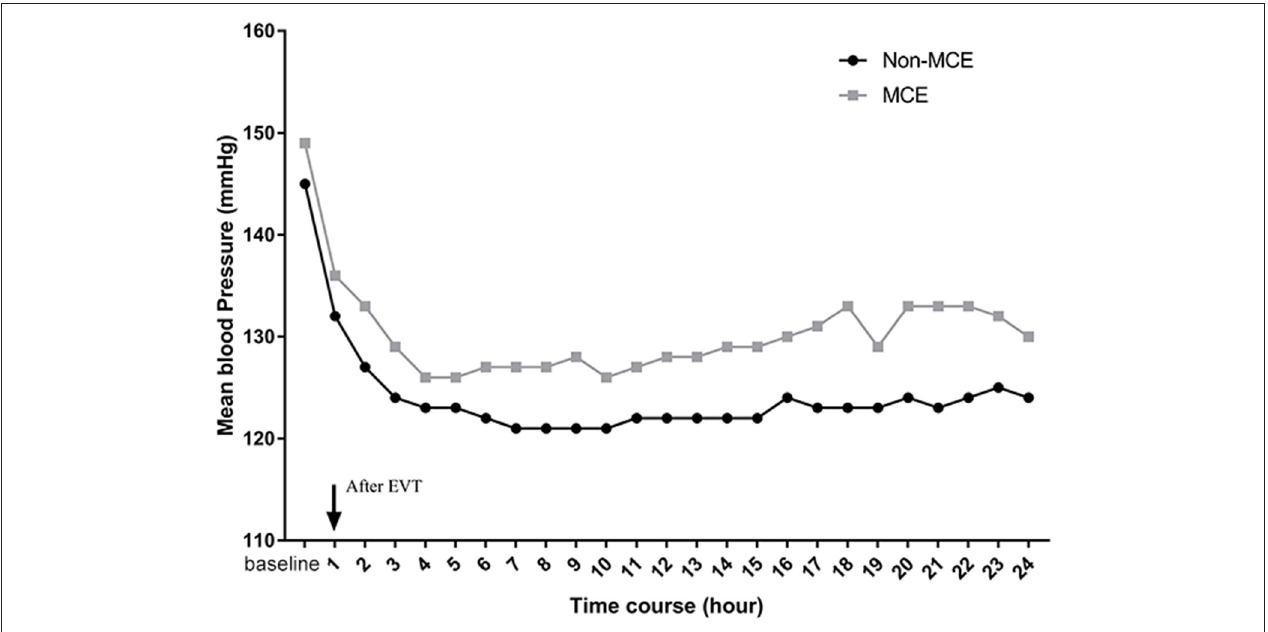
FIGURE 2 | Serial SBP levels plotted according to the development of MCE.